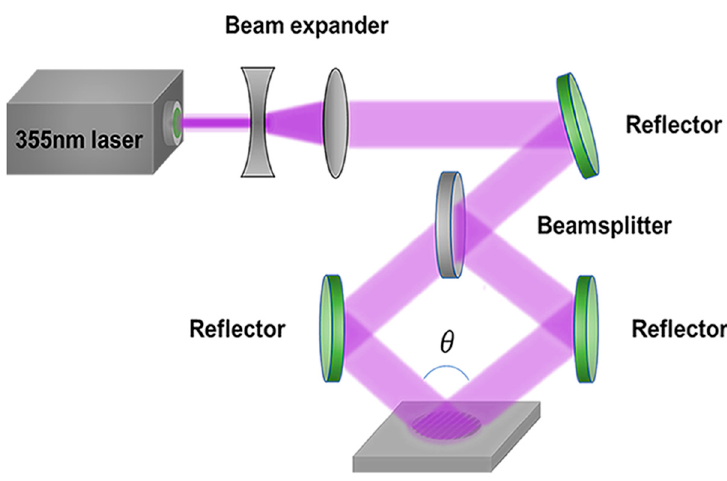
Figure 1. Schematic image of the fabrication of periodic microstructures by laser interference.